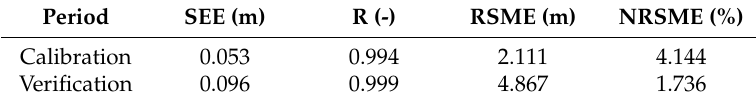
Table 1. Error parameters in the regional groundwater model.